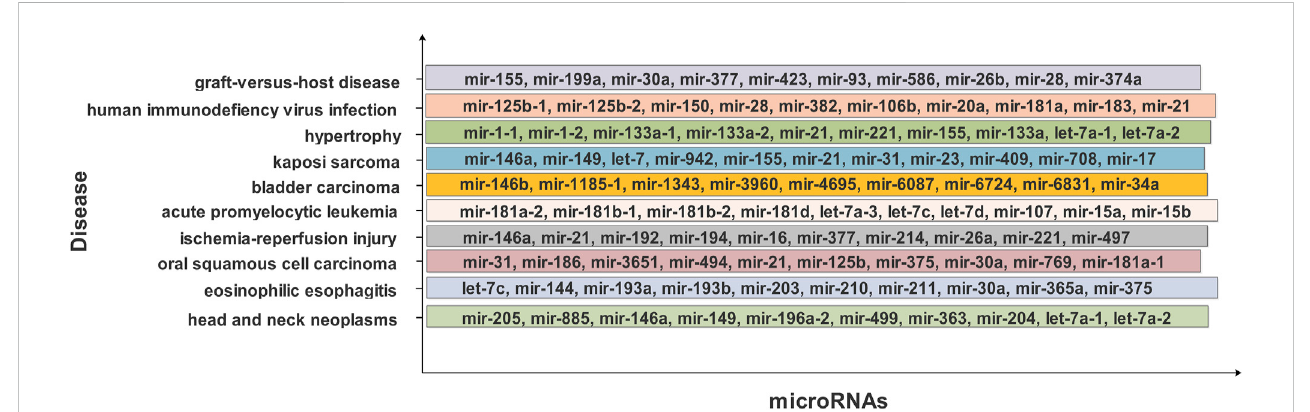
FIGURE 8 The top ranked 10 groups by RobustRankAggrfor thedataset BLCA. The name of thedisease/group isshown atthe y -axis and the bars denote theset of associated